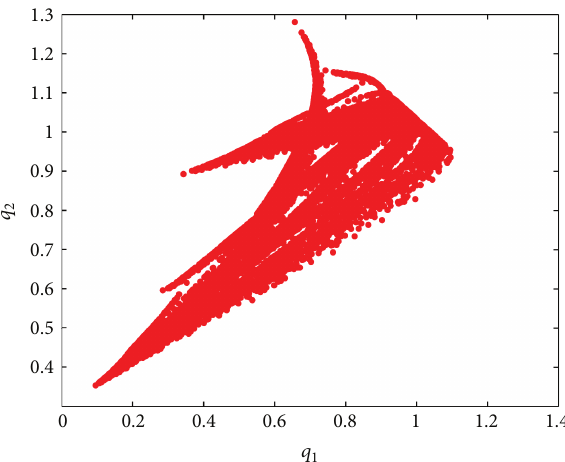
Figure 5: Chaos attractor of system (6) for 𝛼 1 = 2.13 and 𝛼 2 = 1.46 .